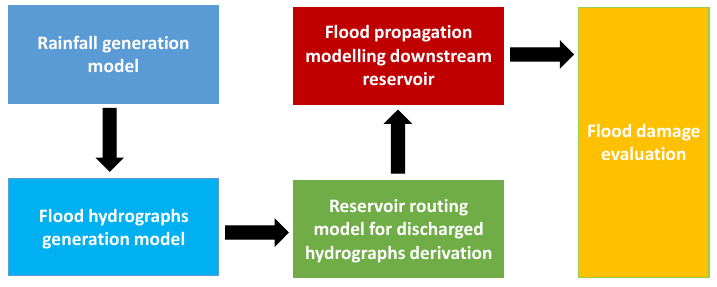
Figure 2. Layout of the proposed procedure.